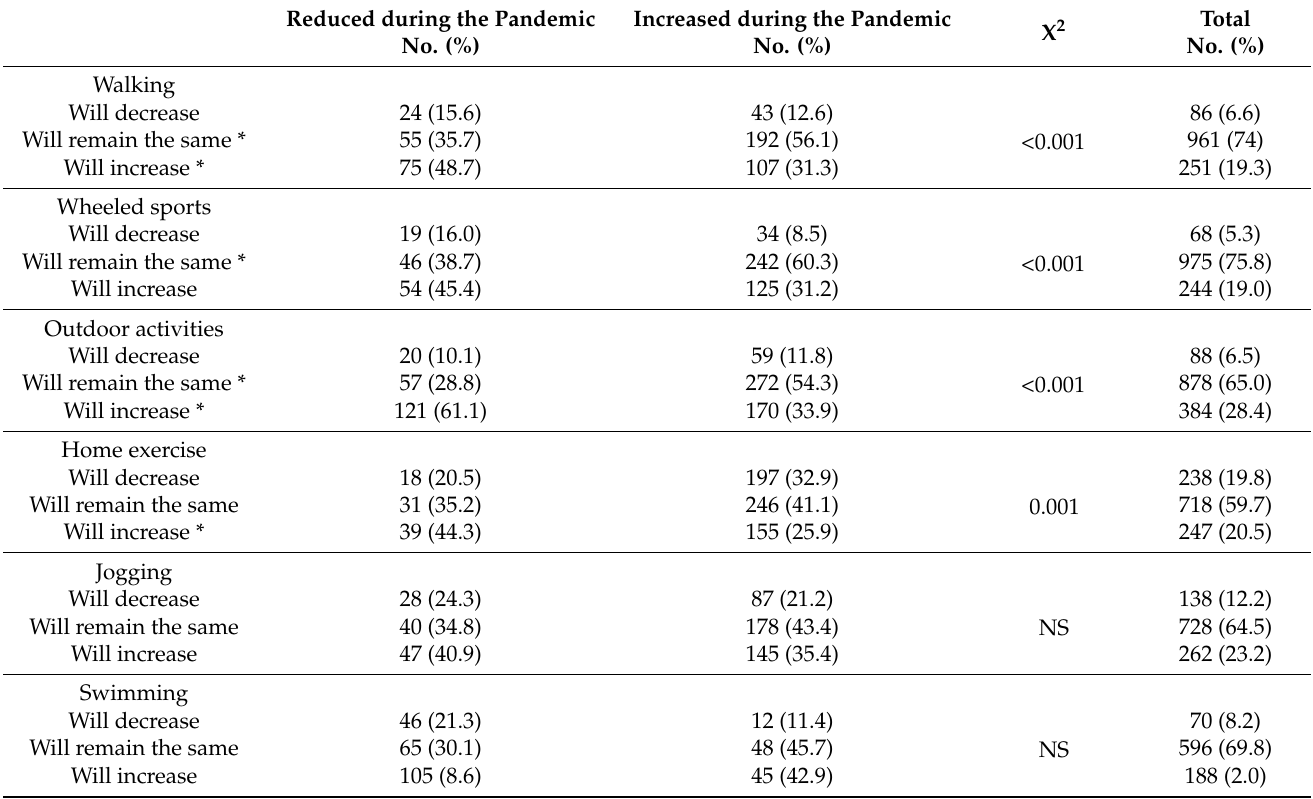
Table 6. Results of post-pandemic physical activity